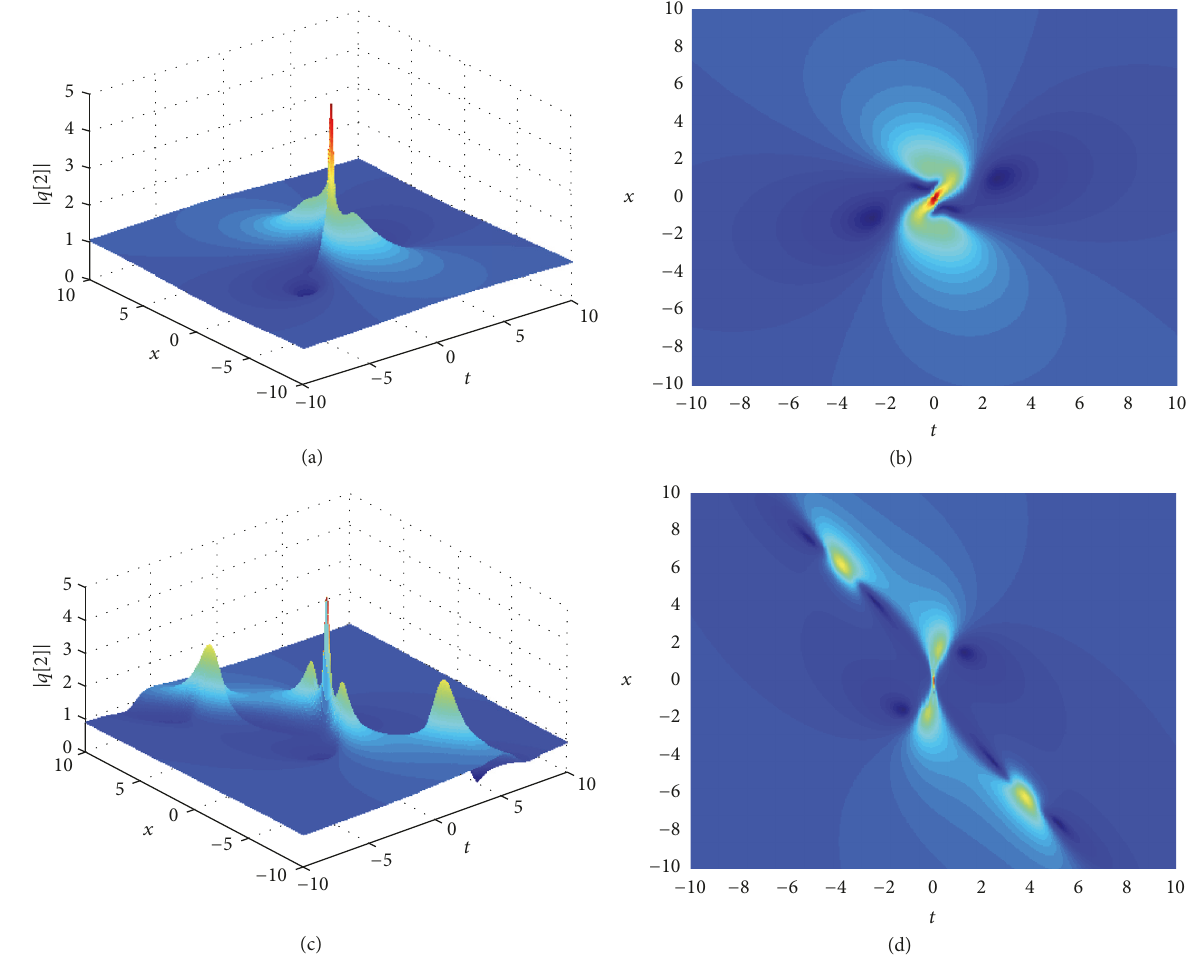
Figure 2: (a) The second-order rogue wave with 𝜀 = 0 and 𝑎 1 = 𝑏 1 = 0 ; (b) the density plot with 𝜀 = 0 and 𝑎 1 = 𝑏 1 = 0 ; (c) the second-order rogue wave with 𝜀 = 0.2 and 𝑎 1 = 𝑏 1 = 0 ; (d) the density plot with 𝜀 = 0.2 and 𝑎 1 = 𝑏 1 = 0